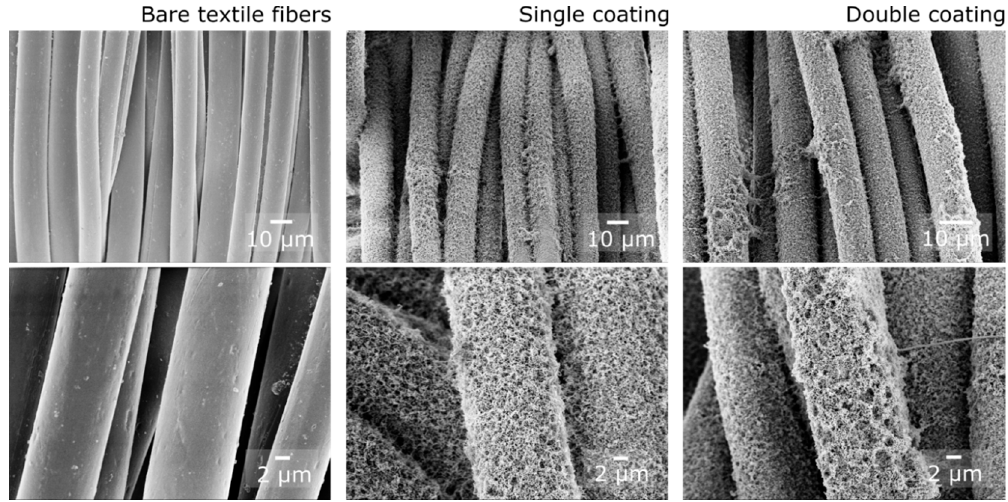
Figure 1. SEM images of polyester fibers before coating, after a single coating process (1-step), and after a double coating process (2-step), each shown at two magnifications.